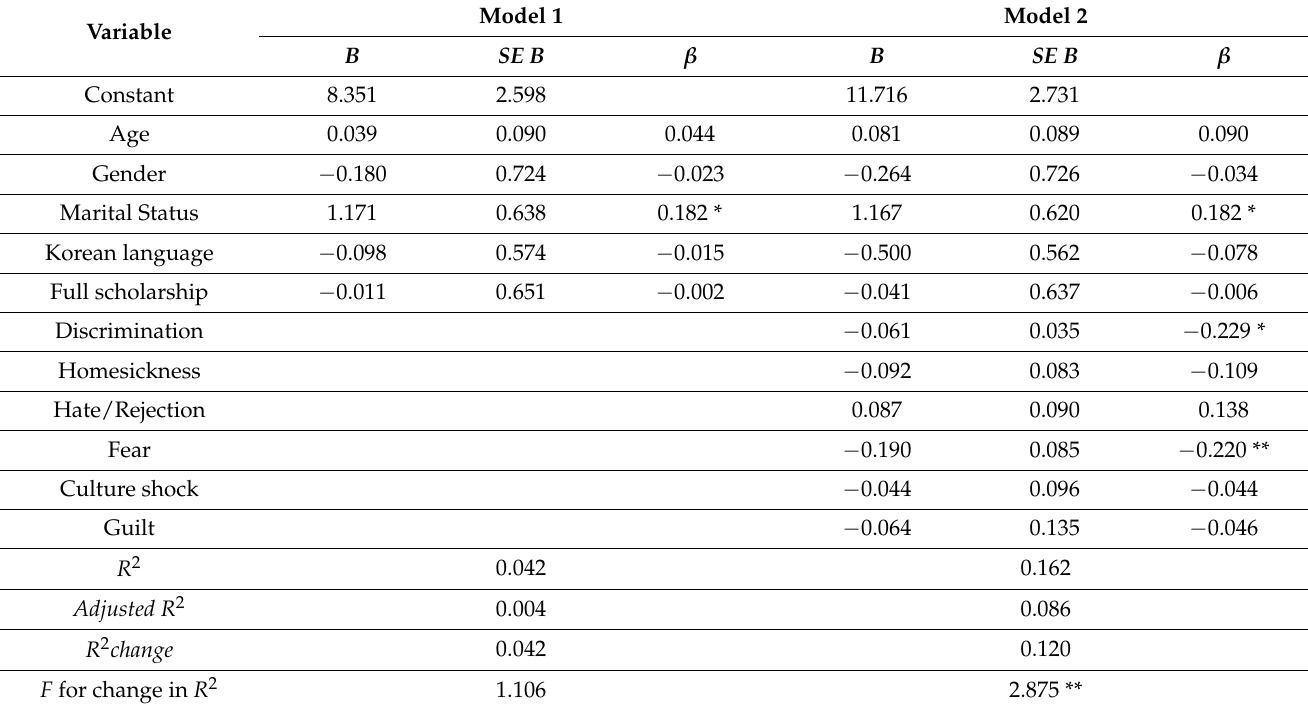
Table 3. Hierarchical linear regression